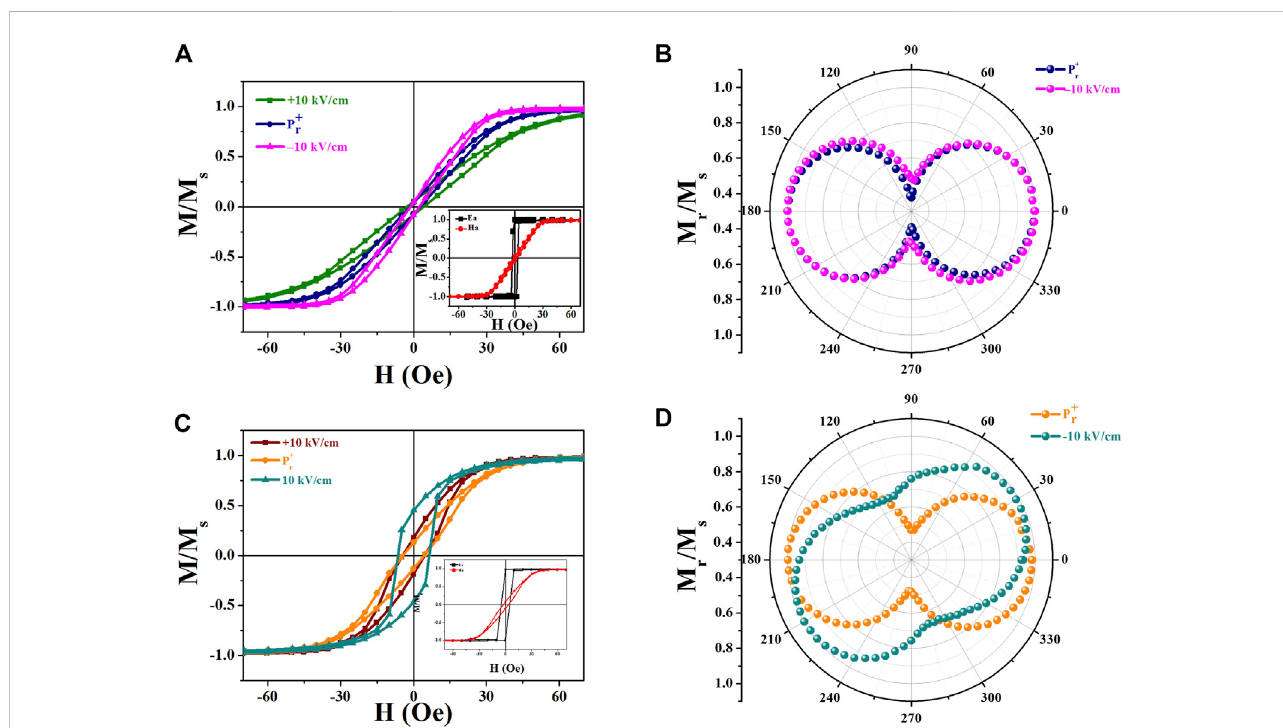
FIGURE 1 Magnetic hysteresisloops atthehard axisunder various electric fi eldsfor theCoZr layeralong (A) (01 – 1)and (C) (100) ofthePMN – PTsubstrate; rotating angle-remanentcurvesundervariouselectric fi eldsfortheCoZrlayeralong (B) (01 – 1)and (D) (100)ofthePMN – PTsubstrate.Inset:magnetichysteresisloops at the easy and hard axes at the P 0